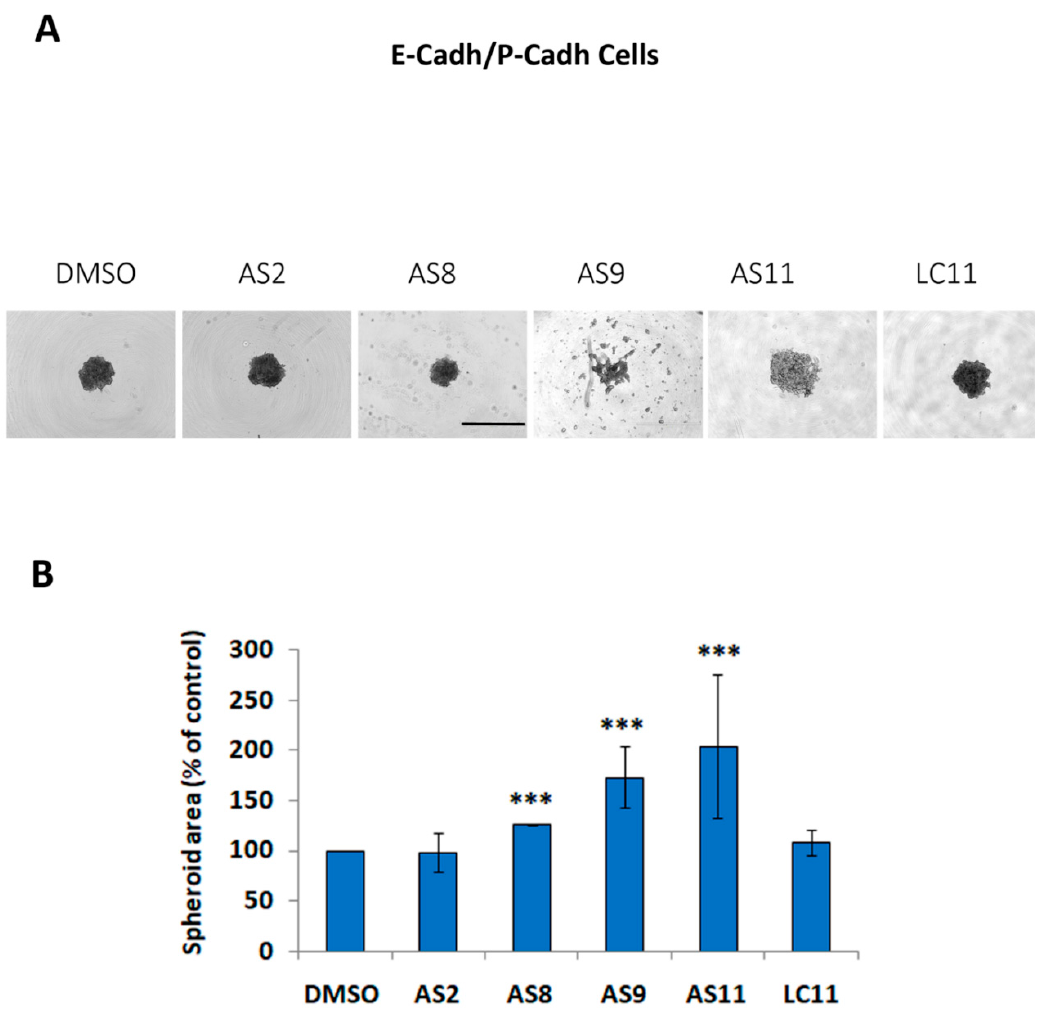
Figure 2. AS11, AS9, and, to a lesser extent, AS8 regulate cell–cell adhesion. BxPC-3 E-cadh / P-cadh cells were incubated in the presence of either 0.1% DMSO or 0.05 mM AS2, AS8, AS9, AS11, or LC11 and allowed to form spheroids in suspension for 24 h. ( A ) Representative pictures of spheroids. Scale bar: 1000 µ m. ( B ) The spheroid area was measured by phase-contrast microscopy and analyzed by ImageJ. Values represent the mean of two experiments performed in octuplet. A p < 0.05 was considered statistically significant and is indicated by ‘***’ when p < 0.001. See the Materials and Methods section for details on the statistical analysis.